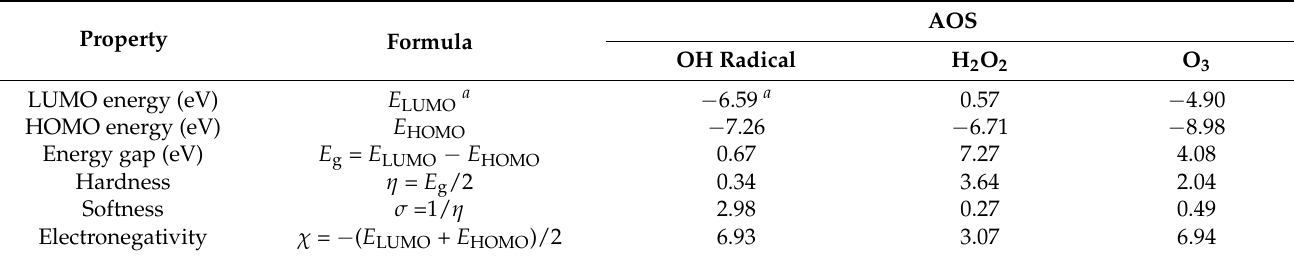
Table 5. Reaction parameters for the active oxygen species (AOSs) obtained via the frontier orbital analysis at the B3LYP/6-31G(d) level of theory.